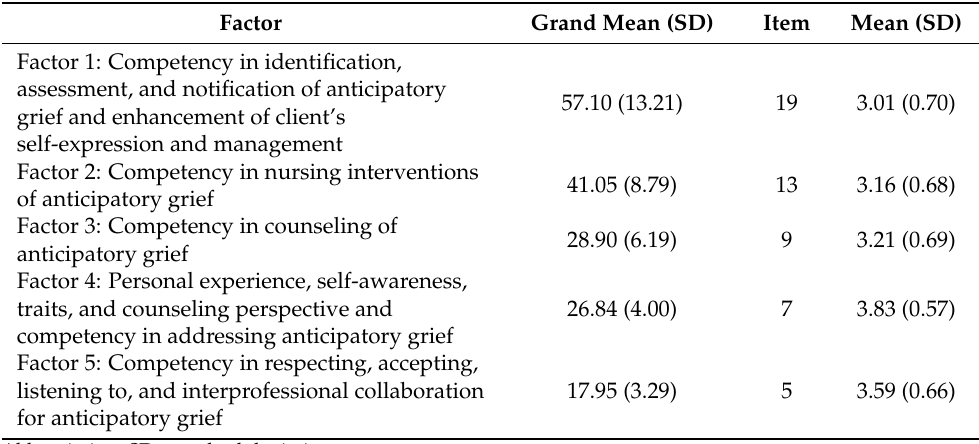
Table 3. Grand means, means, and standard deviations of the five factors of the Anticipatory Grief Counseling Competency Scale (n =